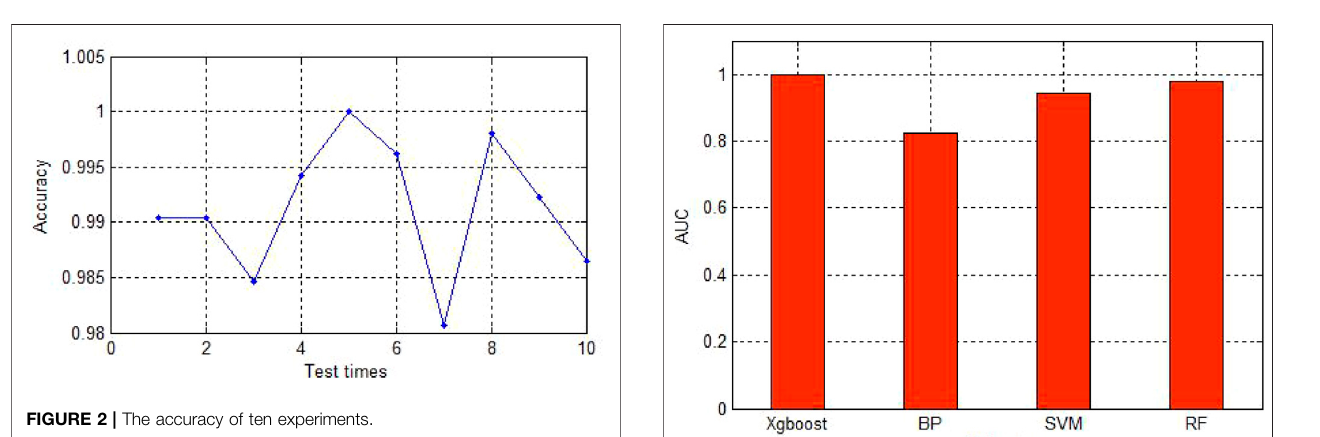
FIGURE 2 | The accuracy of ten experiments.